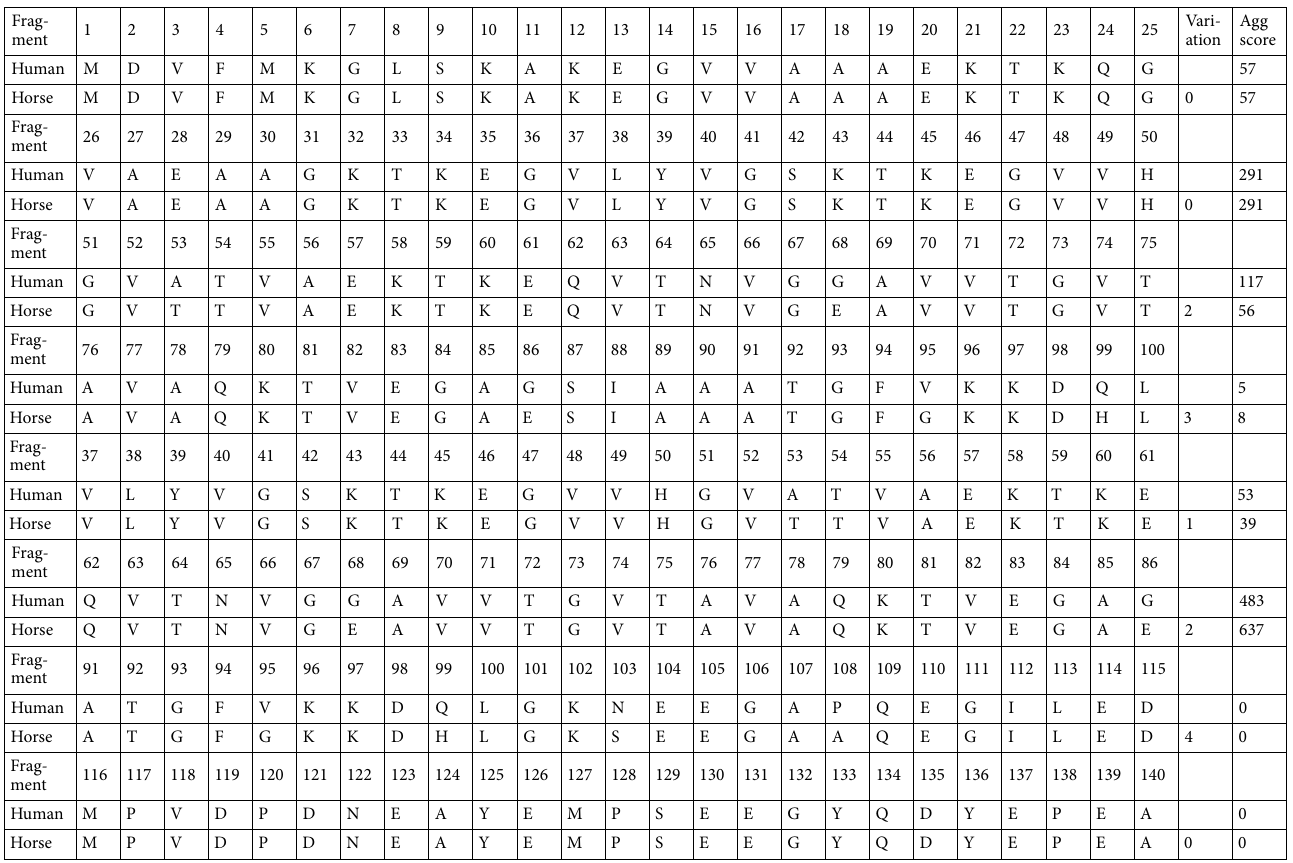
Table 2. Human ( Homo sapiens ) and horse ( Equus caballus ) α-synuclein (α-syn) amino acid sequences. The 140 amino acid α-syn protein consists of three regions: N-terminal amphipathic region (residues 1 to 60), hydrophobic non-amyloid-β component (NAC) (residues 61–95) and the acidic C-terminal region (residues 96–140). Tango bioinformatic aggregation scores (35–37) of the full-length human and equine α-syn are 896 and 1042, respectively. Aggregation scores for each segment of the human and equine α-syn. Peptide are provided in the right-sided